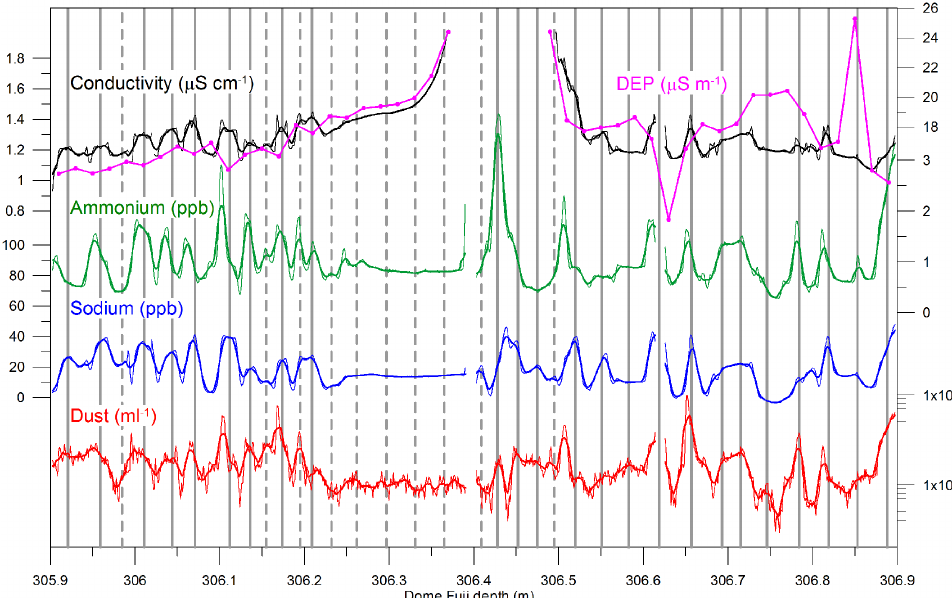
Figure 4. Same records as shown in Fig. 3 plus the DEP record for the section containing the major acidity peak P3 centred at around 306.44m depth and the “peculiar event” with unusually smooth profiles 306.25–306.40m depth. Thin curves show the records at a 1mm depth resolution and thicker curves are 1cm averages. “Certain” and “uncertain” annual layer marks are indicated with full and dashed vertical lines, respectively. For the interval 306.25–306.40m the layer indication is